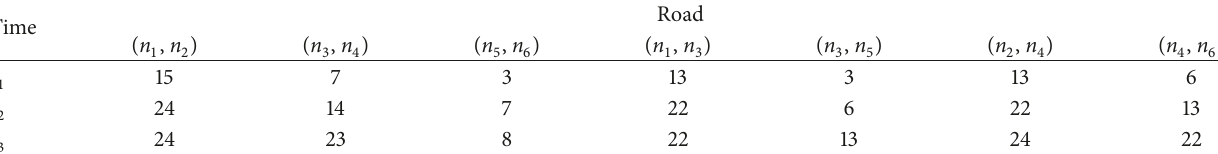
Table 5: Road risk level of the network in Figure 2 by improved